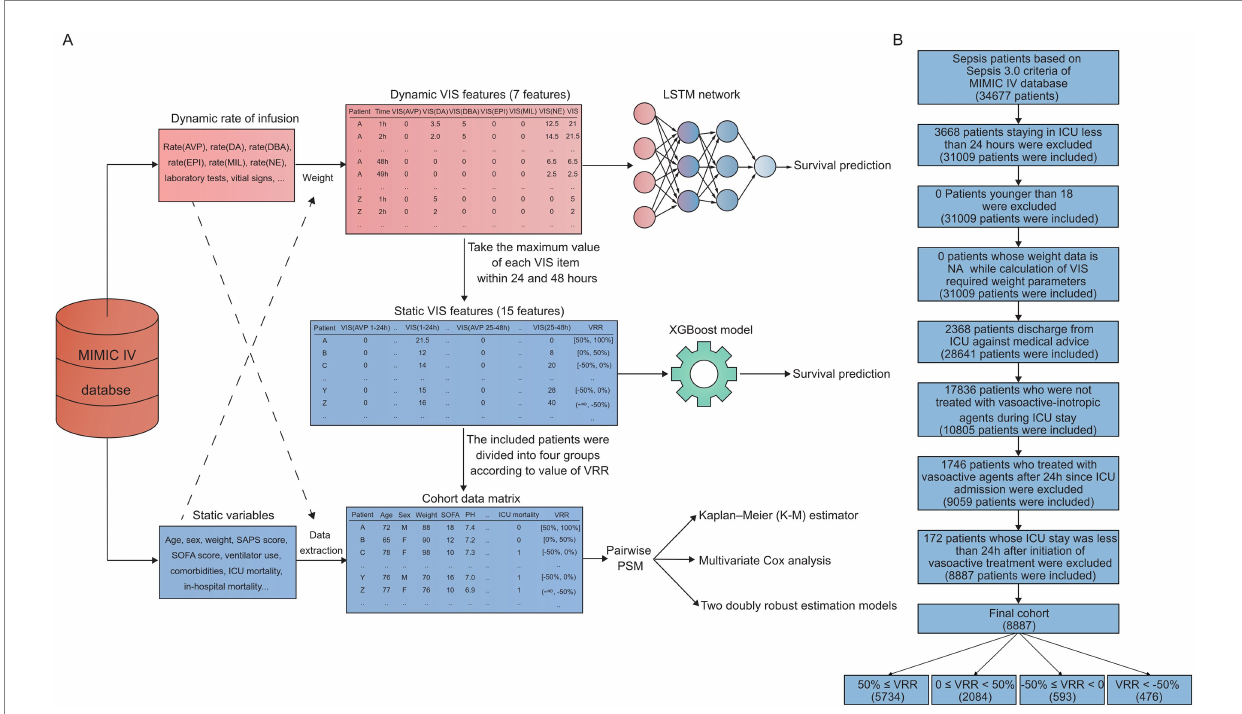
FIGURE 1 Schematic illustration and flow chart. (A) Raw data were obtained from the MIMIC-IV databases. A survival prediction model was trained using an LSTM network, which was updated hourly. Static VIS data were characterized by 15 features, including VRR and VIS features at 1–24 h and 25–48 h, respectively, which were extracted based on the dynamic VIS data. Then, according to the results of machine learning, we selected the most representative feature, VRR, for further statistical analysis. LSTM, long short-term memory; VIS, vasoactive–inotropic score; VRR, VIS reduction rate; AVP, vasopressin; DA, dopamine; DBA, dobutamine; EPI, epinephrine; MIL, milrinone; NE, norepinephrine. (B) The study flow